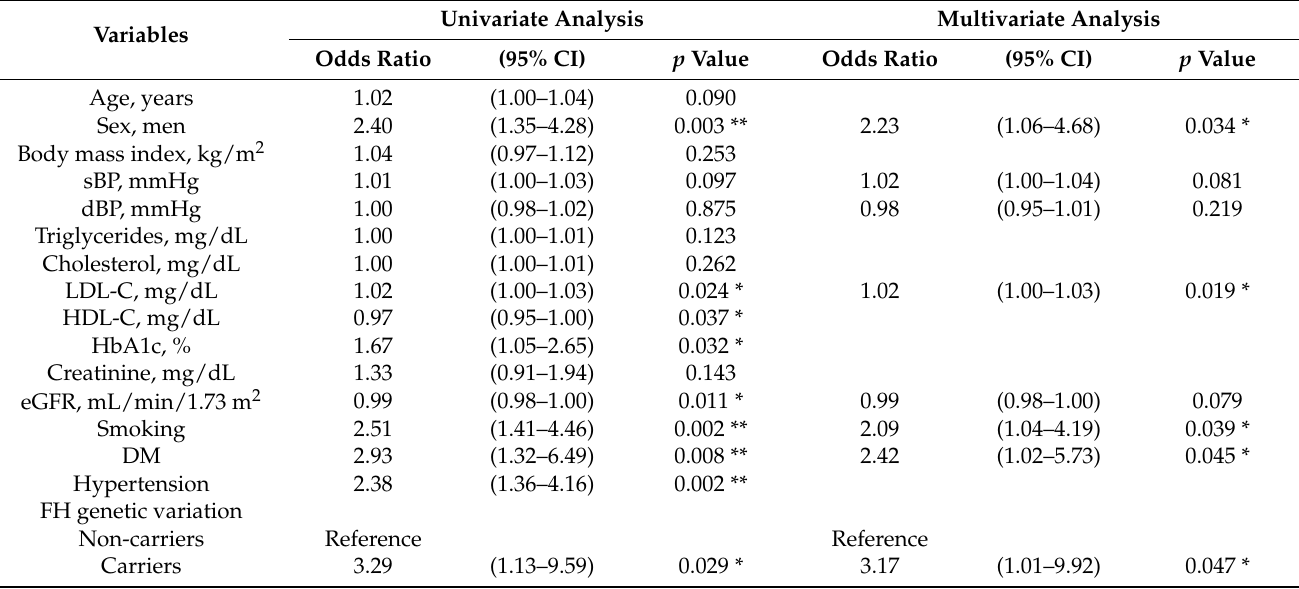
Table 4. Association between the variables and the incidence of cardiovascular disease or mortality as determined by univariate and multivariate regression analyses in the study cohort (n =